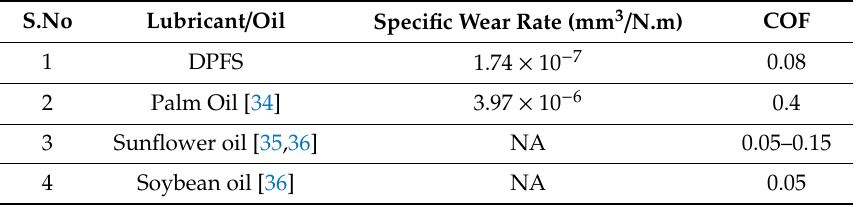
Table 8. Comparison of DPFS performance with a few other vegetable